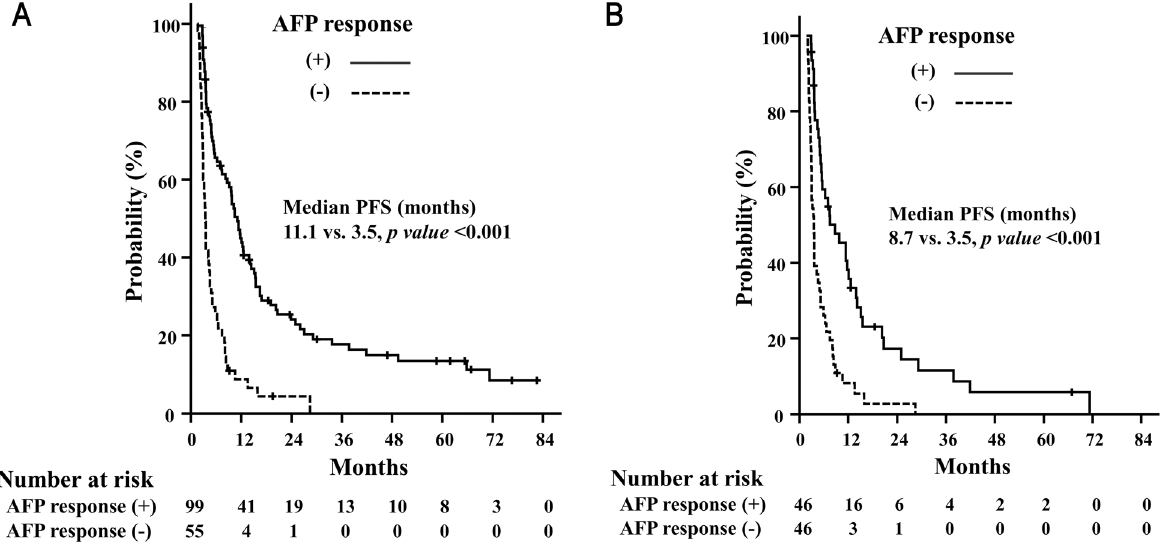
Fig 3. Progression-free survival rates. Progression-free survival (PFS) rates depending on the AFP response in all patients (A) and in the propensity score-matching cohort (B).